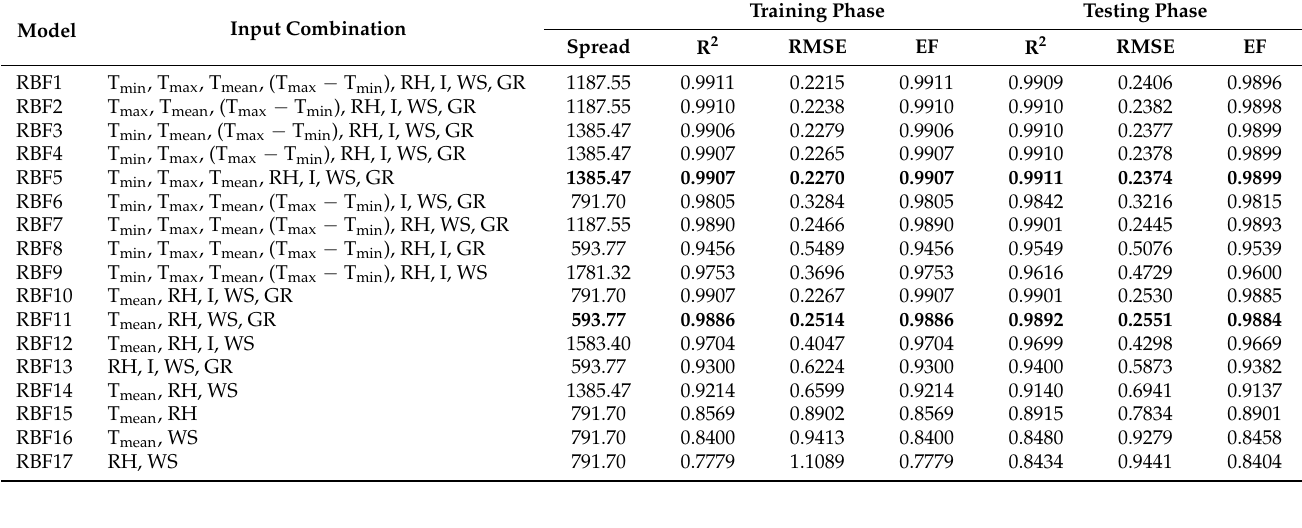
Table 5. Statistical criteria for an estimation of ET 0 using different input variables for RBF. The bold part shows that this model is superior to others.